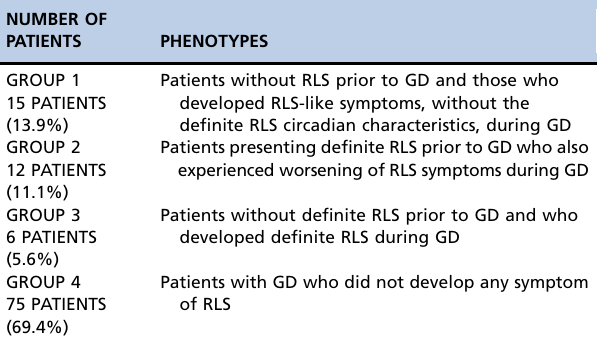
Table 1 - Phenotypes in relation to RLS-like symptoms obtained in this